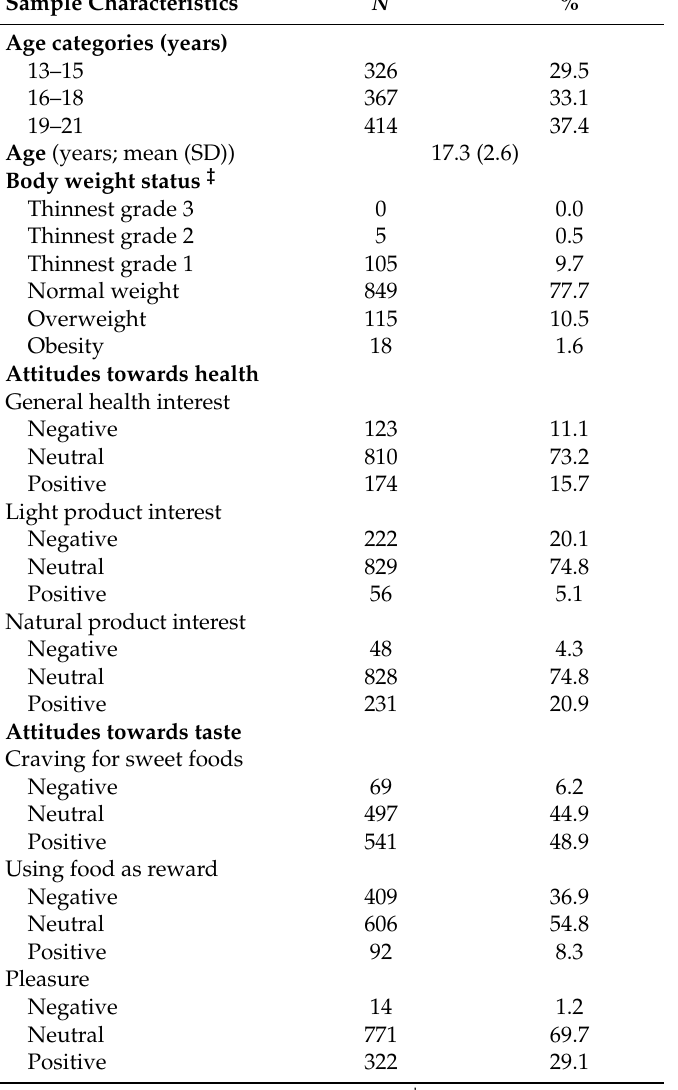
Table 2. Sample characteristics, the GEBaHealth Study ( n = 1107) †